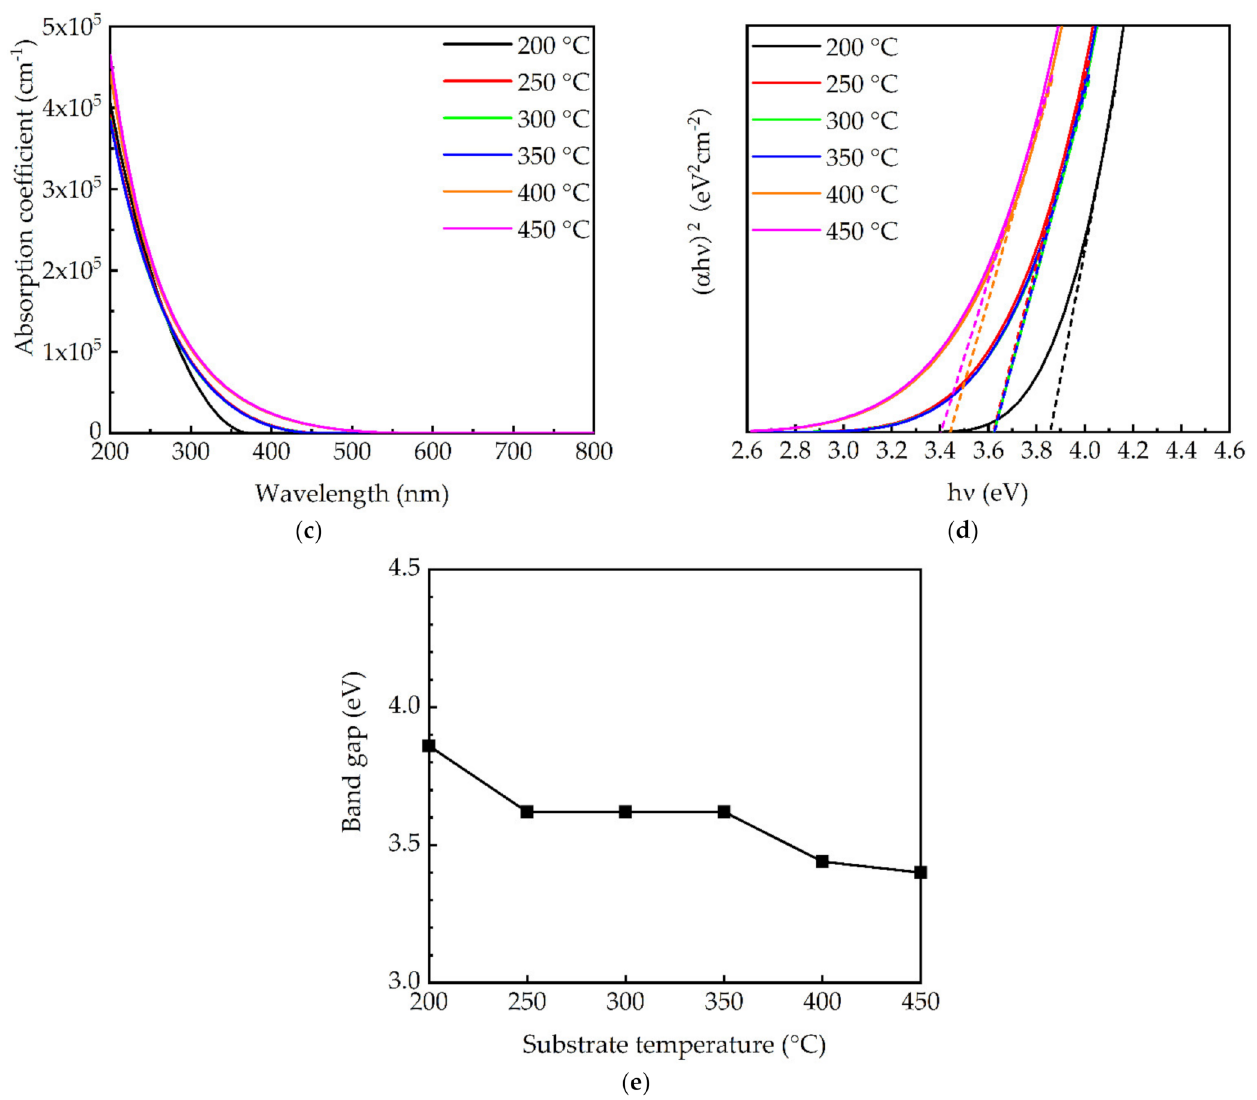
Figure 9. ( a ) Refractive index spectra, ( b ) transmittance spectra, ( c ) absorption coefficient spectra, ( d ) curves of ( α h ν ) 2 versus h ν , and ( e ) band gap for GaN films prepared at different substrate temperatures.